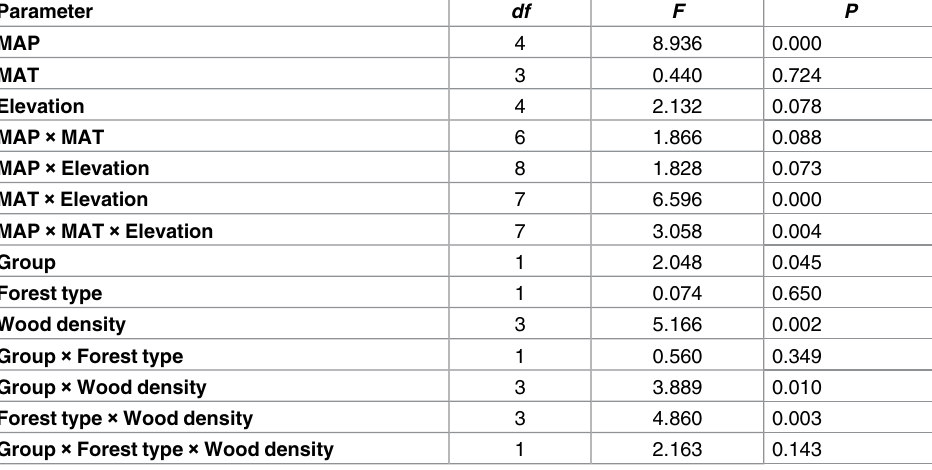
Table 2. Multi-way analysis of varianceof tree mortality rate for mean annual precipitation (MAP), mean annual temperature (MAT), elevation, group, forest type, and wood density. Group includes angiosperm and gymnosperm species; forest type includesevergreenand deciduous